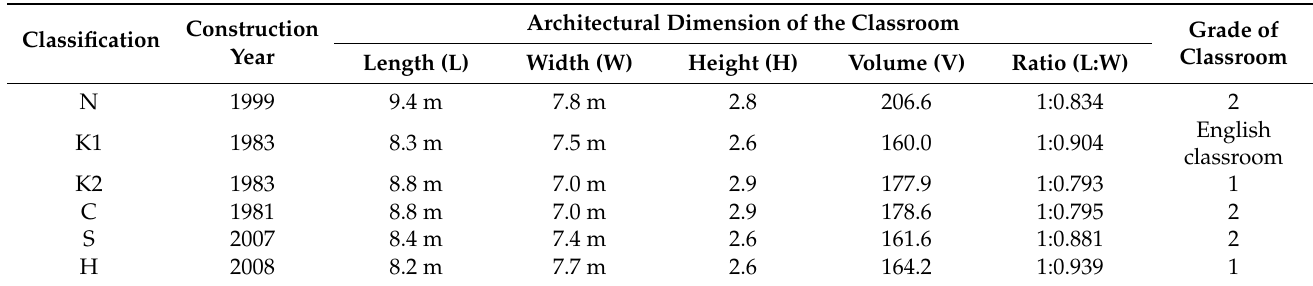
Table 4. Information about the classification and grade of